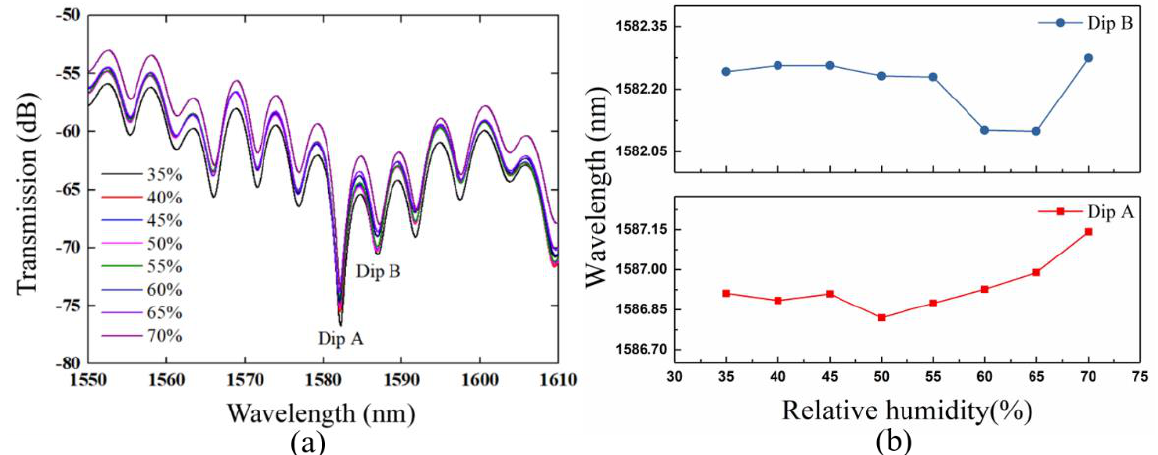
Figure 13. ( a ) Transmission spectrum of the sensor at the relative humidity from 35% to 70%. ( b ) Wavelength fluctuation of dip A and B at the relative humidity from 35% to 70%.